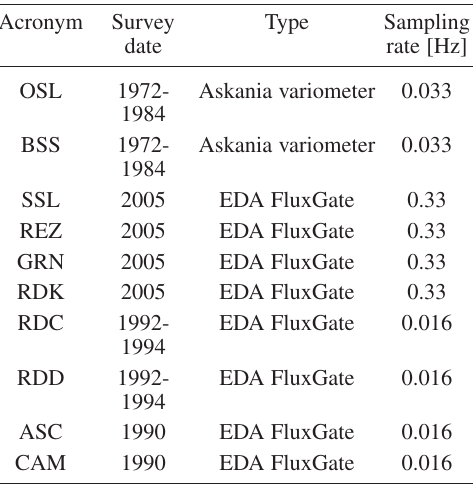
Table I. Timing, type and sampling rate of MV sta- tions of fig.